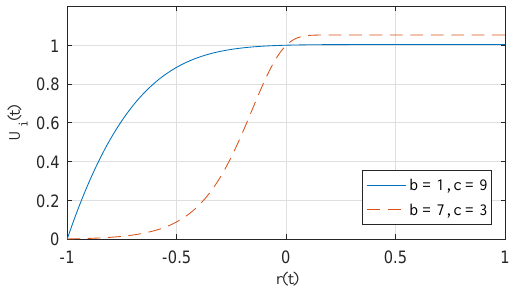
Figure 5. Proposed utility